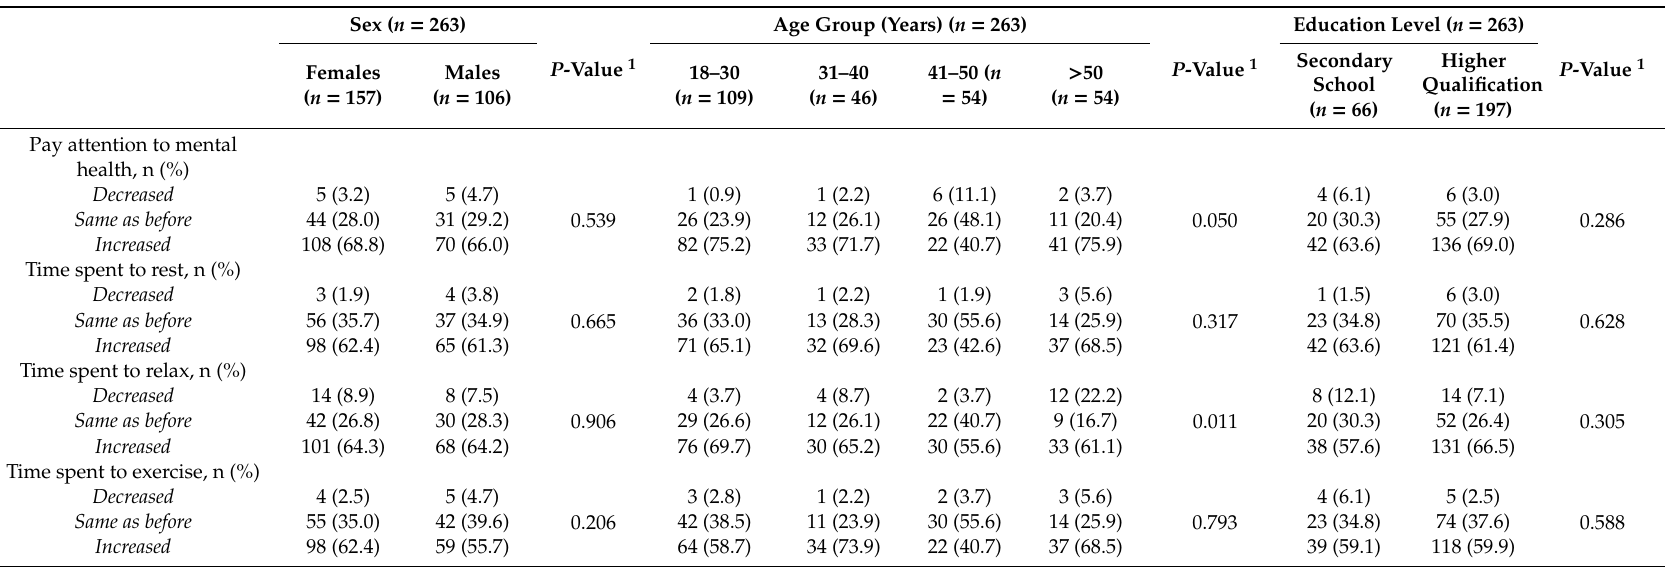
Table 5. Awareness and lifestyles by demographic